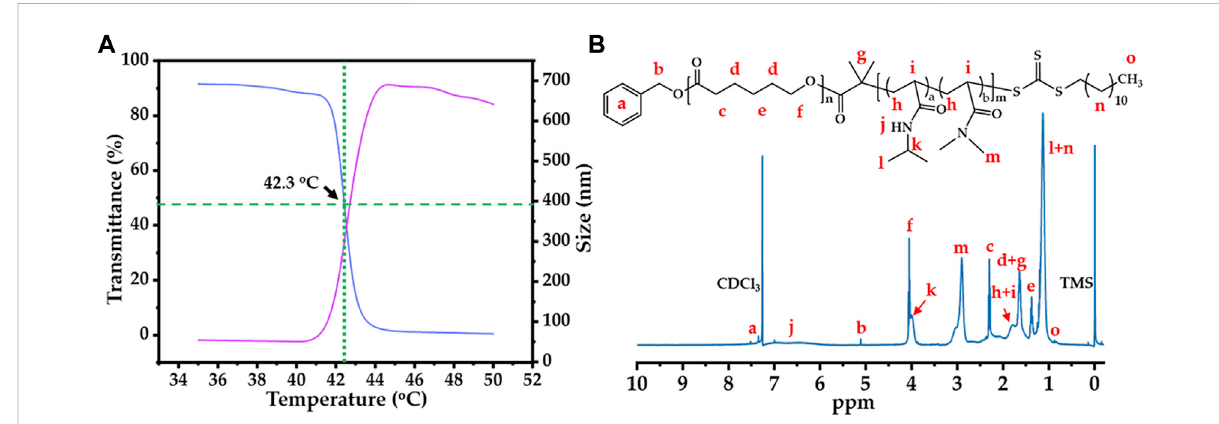
FIGURE 2 Thermo-sensitivity and structure of PCL- b -p(N- co -D): (A) temperature-dependenttransmittance curve and diameter variation of PCL- b -p(N- co -D), low critical solution temperature (LCST): 42.3 ° C; (B) 1 H NMR spectrum of PCL- b -poly(N- co -D), marking all characteristic